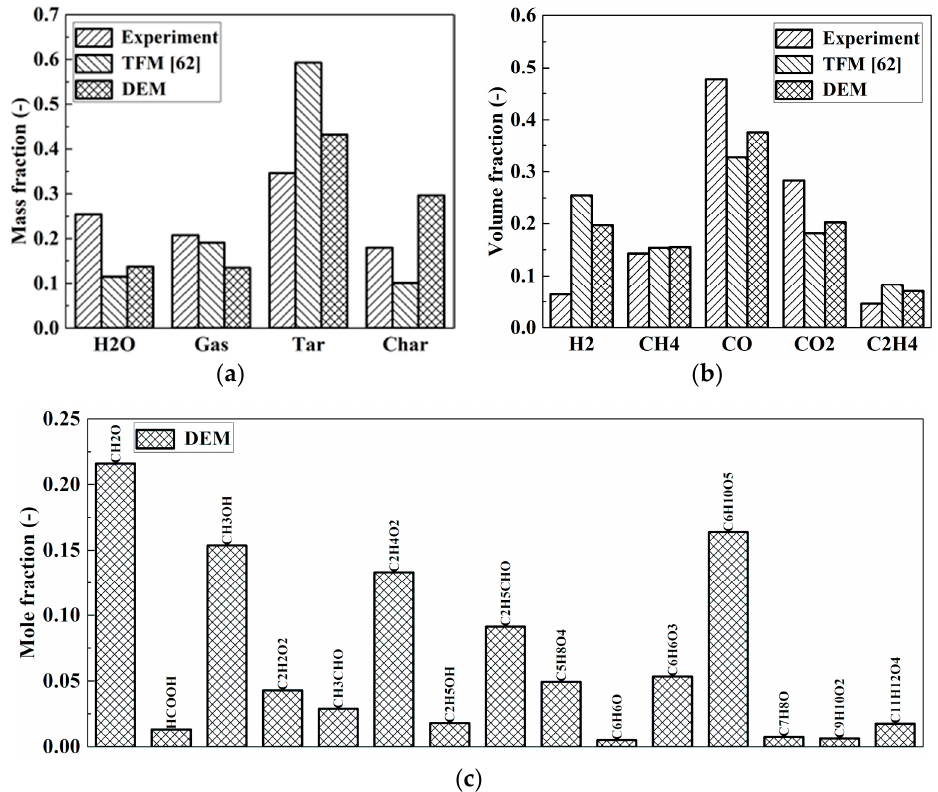
Figure 3. Pyrolysis products. ( a ) H 2 O, light gas, tar, and char; ( b ) light gas species; and ( c ) tar species.